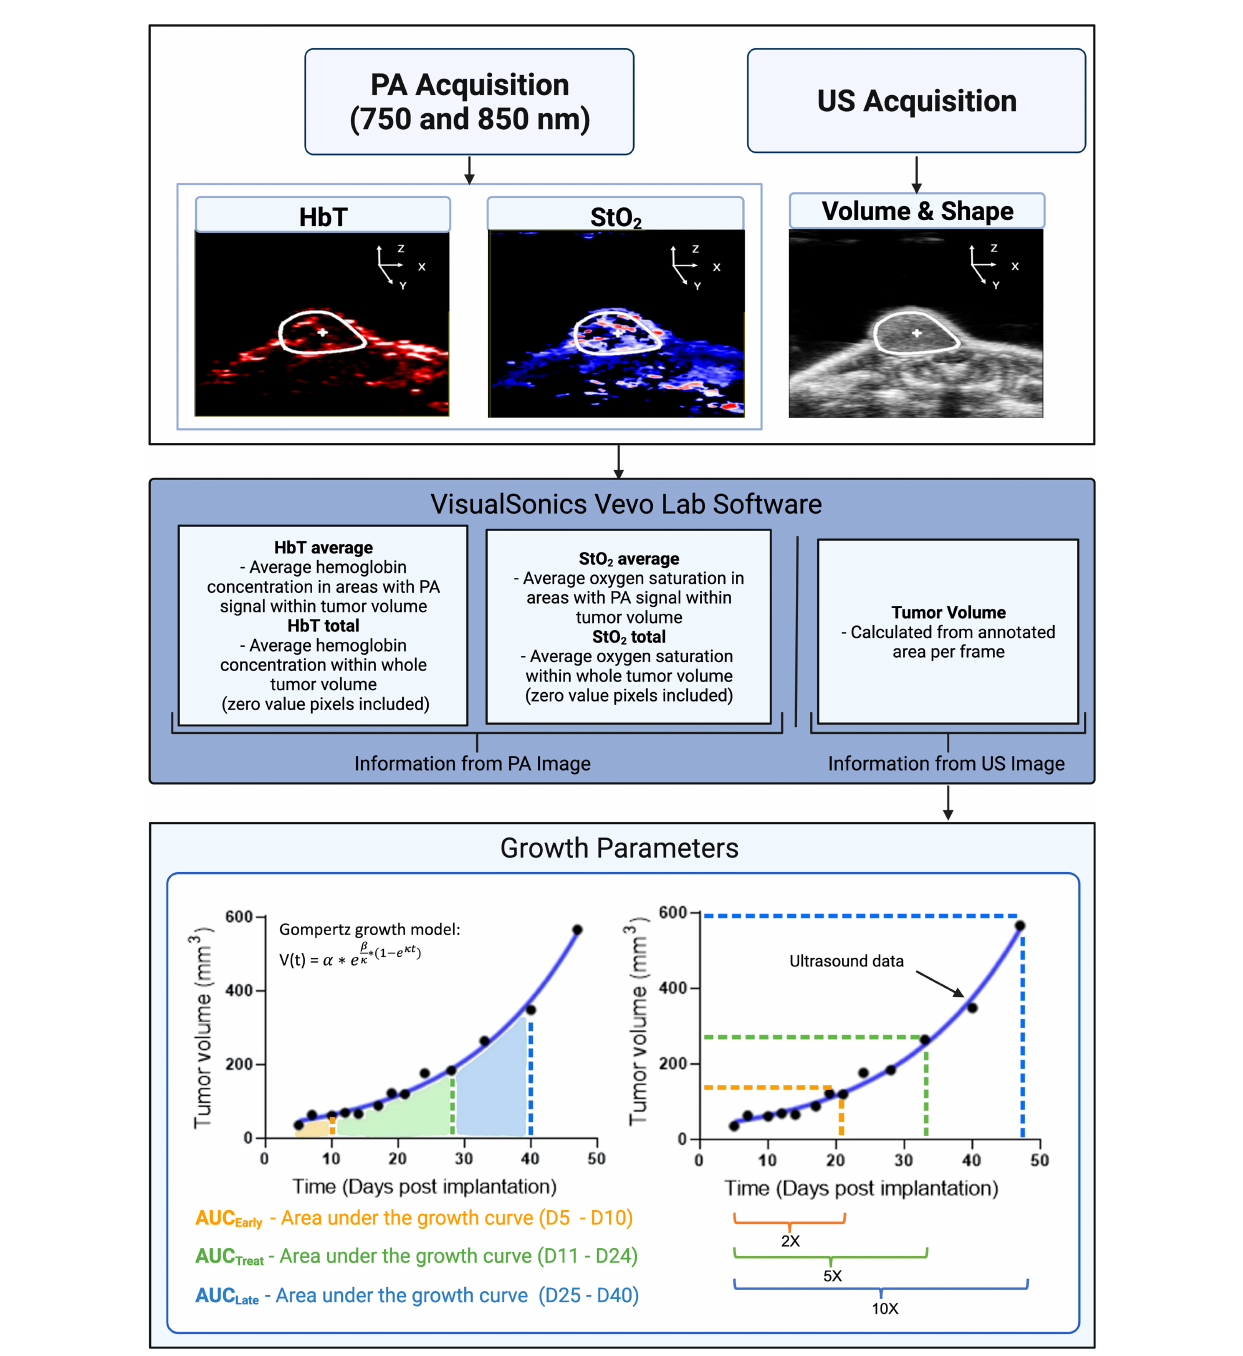
FIGURE 2 | A fl owchart depicting the steps involved in collecting and analyzing relevant data in our experiment. Inputs consist of StO 2 , HbT (from photoacoustic images), and tumor volume (extracted from ultrasound images). Tumor volume gathered from ultrasound images was plotted for various days post-implantation. The data were fi tted with the Gompertz growth model. Shown in the bottom left schematic representation is the area under the curve (AUC) for different time periods during the study. AUC Early (orange shaded area) is area under the volume vs. time plot during the pretreatment days (D5 – D10). AUC Treat (green shaded region) represented the AUC for time period D11 – D26 when the mice were treated with cabozantinib. AUC Late (blue shaded region) is the AUC for time period D26 – D40. AUC parameters units are mm 3 * day. The bottom right image is a schematic representation of the tumor volume vs. days post-implantation curve utilized to determine the 2×, 5×, and 10× growth parameters. 2× is the number of days it takes for a tumor ’ s pretreatment (D5) volume to double in size. Green (5×) and blue (10×) show the number of days it takes for pretreatment volume to increase by factors of 5 and 10, respectively. X-fold increase parameters are measured in terms of days post-implantation. PA and US represent photoacoustic and ultrasound, respectively. Created with